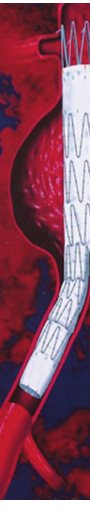
Figure 1: Bifurcation stenting.